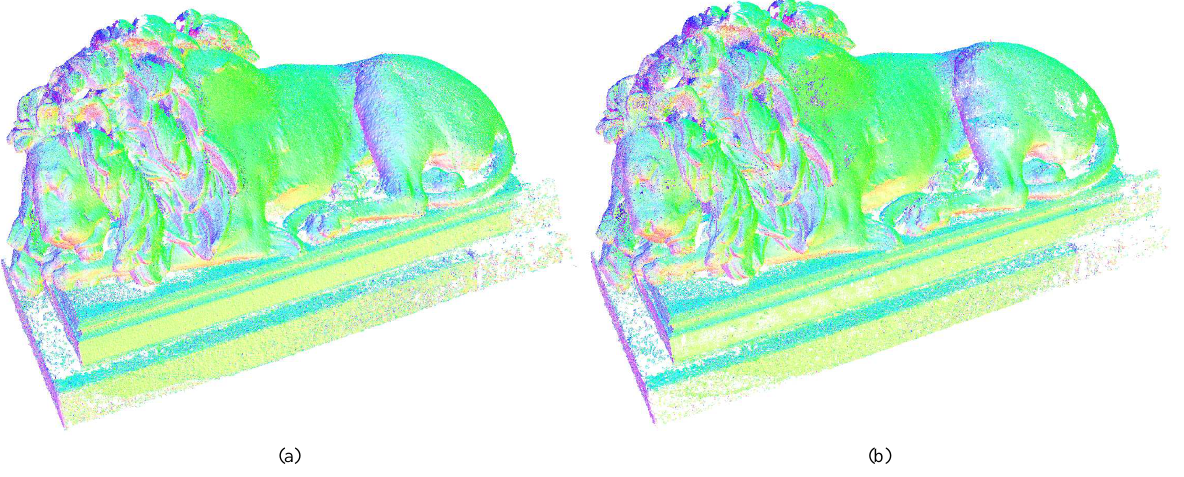
Figure 5: Resulting color coded normals of the lion data set. (a): RQT error threshold ǫ = 1 . 0 . (b): RQT error threshold ǫ = 1 . 2